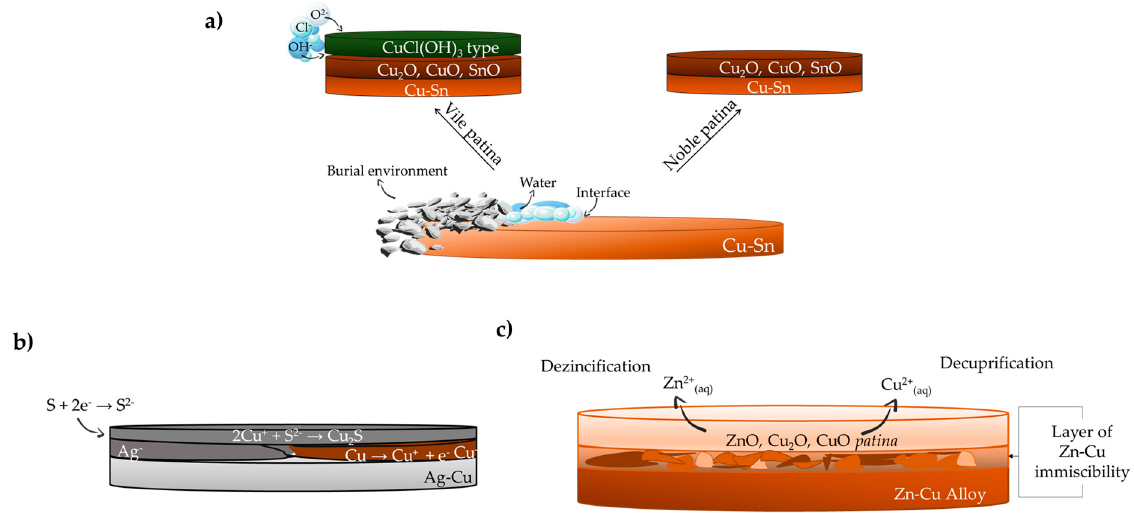
Figure 1. Schematized corrosion process of ( a ) bronze, ( b ) silver, and ( c ) brass with the formation of alteration compounds on the metal surface. Table 1. List of the most common corrosion products on di ff erent metal